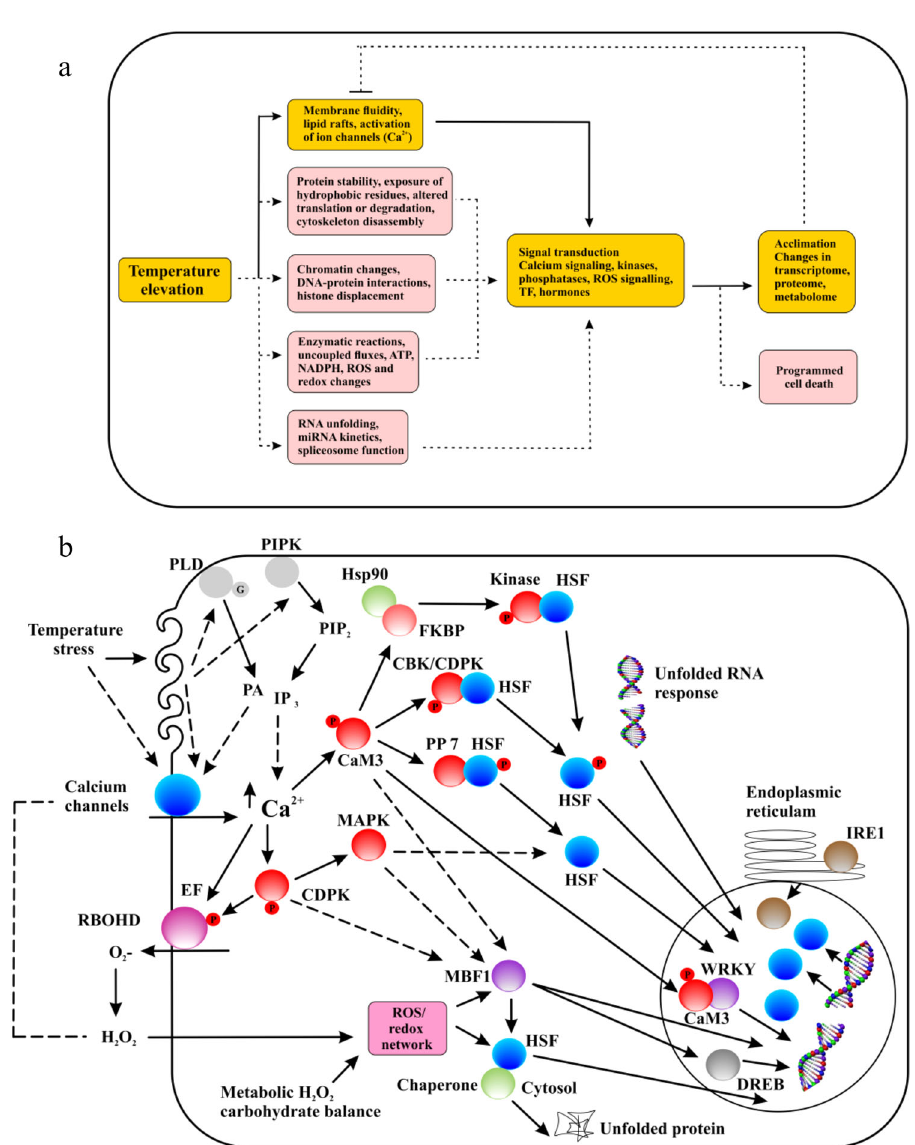
Fig. 4 Temperature-sensing scheme in algae. a Changes in temperature impact diverse processes in algae. Even a small change in temperature can alter algal membrane properties and subsequently activate calcium channels. The in fl ux of calcium activates signal transduction and regulates intracellular metabolism in an acclimation process. The highlighted yellow pathways and linked solid arrows indicate primary temperature sensing mechanisms in algae and plants, respectively. Temperature changes induce further modi fi cation in protein stability, which may trigger the unfolded protein response (UPR) in the cytosol and endoplasmic reticulum (ER), ROS accumulation, changes in cellular energy levels, and — unfolding of RNA, which might act as riboswitches and/or impact spliceosome- and microRNA-in fl uenced metabolic functions. Pathways (boxes) shown in light pink are thought to activate signal transduction changes that help cells to acclimate. Furthermore, an alternative acclimation mechanism involves the activation of programmed cell death (PCD), which can be induced by a combination of different signal transduction conditions or pathways. b A schematic model showing the signal transduction pathway activated in response to temperature stress in algae. Temperature stress impacts membrane stability and promotes the activation of plasma membrane calcium channels, resulting in inward fl ux of calcium (left side). This membrane stability change may also trigger lipid signaling via the lipid-modifying enzymes phospholipase D (PLD) and phosphatidylinositol-4-phosphate 5-kinase (PPIK). Calcium binds CaM3 (calmodulin) and triggers the transcriptional regulators of the heat stress response (HSR), i.e., heat shock transcription factor (HSR), MBF1c, dehydration-responsive element-binding (DREB), and WRKY. Elevation of calcium in the cytosol also activates the ROS-producing enzyme RBOHD (respiratory burst oxidase homolog D) located in the plasma membrane via direct interaction or through the activation of calcium-dependent protein kinases (CDPKs), which phosphorylate RbohD ( lower left ). ROS derived from RbohD, such as superoxide (O 2 − ), which is converted to hydrogen peroxide (H 2 O 2 ), can cause membrane depolarization and enter cells to activate ROS production and/or the redox signaling network, which in turn activate HSFs and MBF1c. During temperature stress in cells, ROS may accumulate due to metabolic imbalances and activate the same networks. Two unfolded protein response (UPR) pathways are shown; one is located in the ER (ER-UPR) and the other is located in the cytosol (Cyt-UPR). The Cyt-UPR functions through HSFs, while the ER-UPR functions through a sensor molecule (IRE1) and the transcription factors bZIP60, bZIP2817, and bZIP17. In the nucleus, temperature elevation decreases the H2A.Z (occupancy of histone) at HSP promotors ( right side